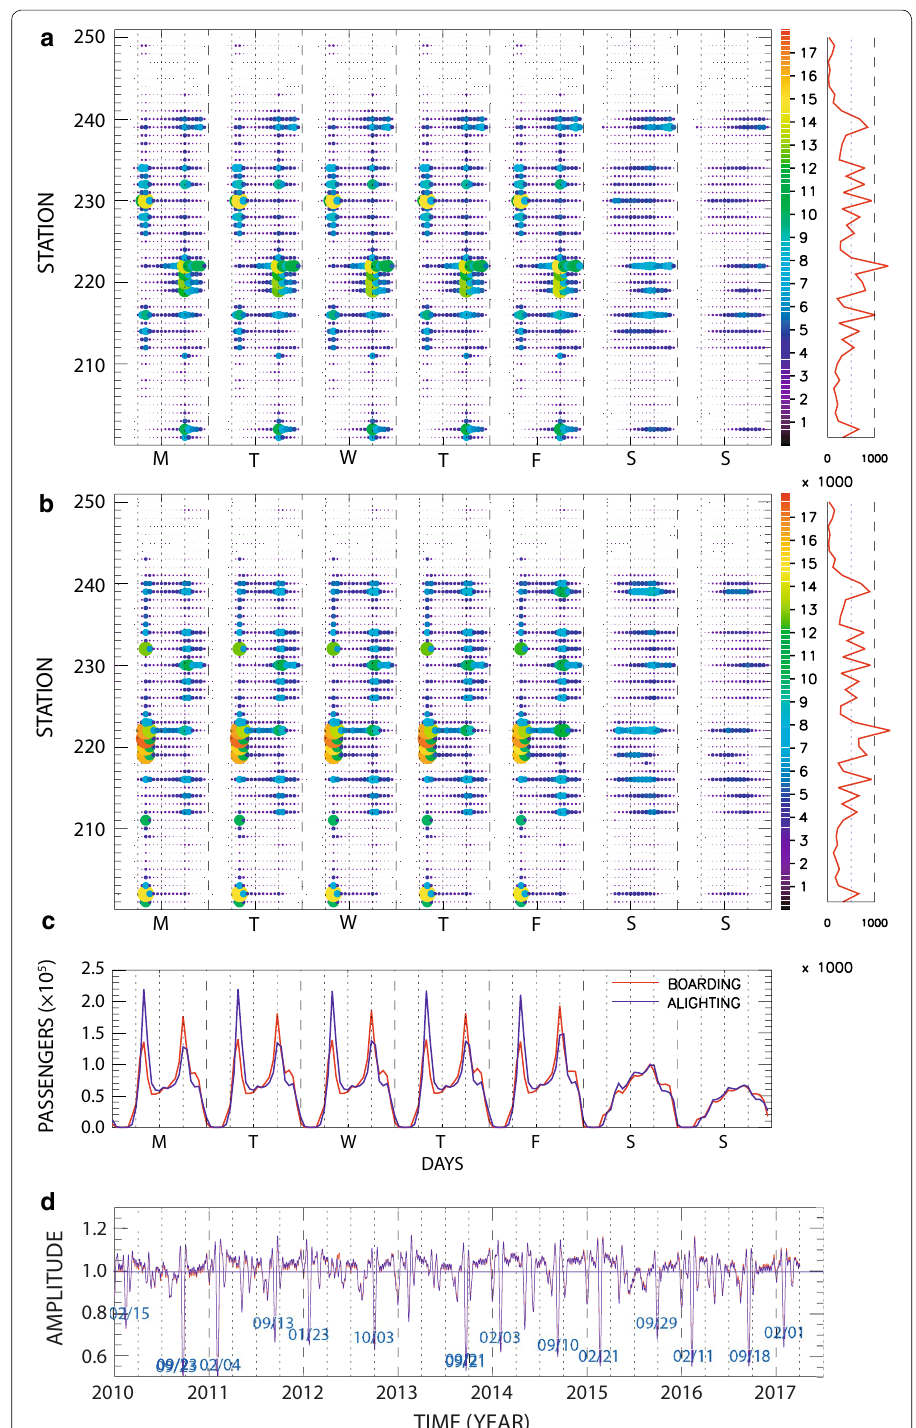
Fig. 3 The first CSEOF mode representing the weekly patterns of passengers for Subway Line #2: a hourly and total number of boarding passengers at each of the 50 subway stations numbered from 201 to 250; b hourly and total number of alighting passengers; c number of boarding (red) and alighting passengers in all stations; and d corresponding amplitude time